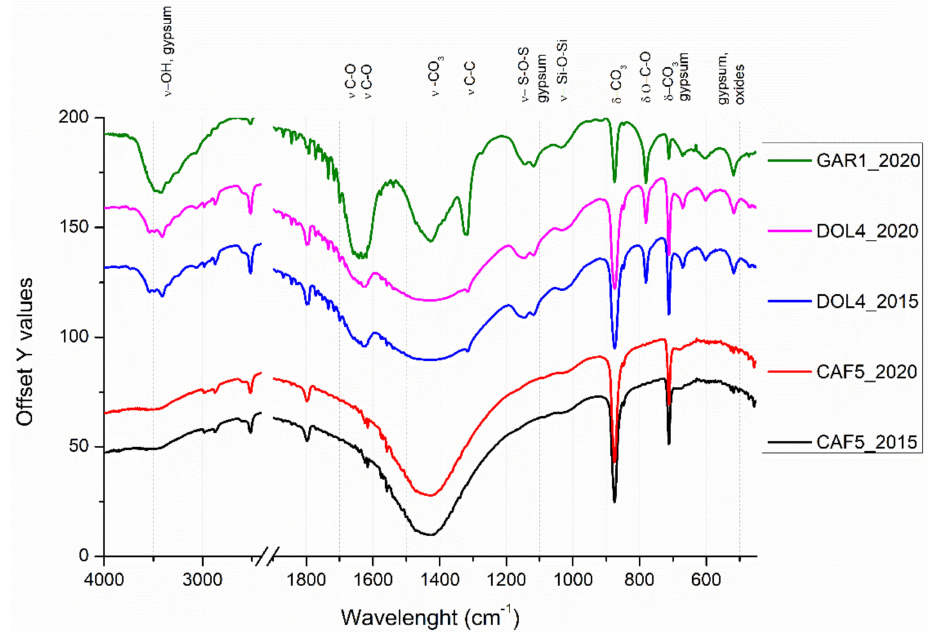
Figure 8. Significant examples of FT-IR spectra collected from sheltered areas of Garzoni Palace (GAR), Ca’ Foscari (CAF), and Ca’ Dolfin (DOL) in the years 2015 and 2020. The main stretching and bending absorption of calcium carbonate, weddellite, and gypsum are